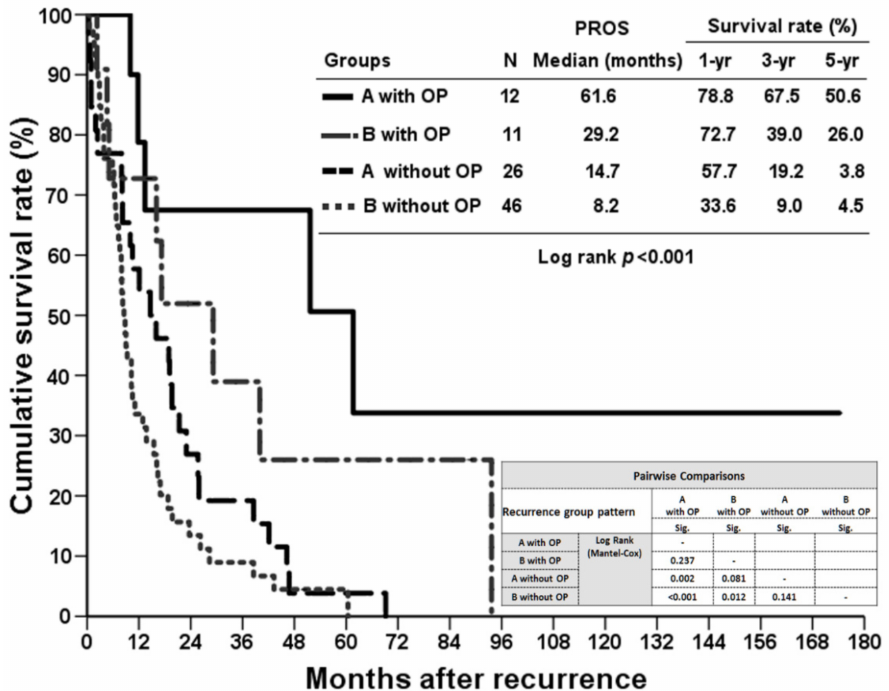
Figure 6. The post-recurrence overall survival (PROS) according to the types of surgery applied within groups A and B. The first line indicates that the patients with isolated intrahepatic recurrence underwent repeat hepatectomy alone in group A ( n = 12), compared to the third line, which represents the nonoperative patients ( n = 26) within group A. The second line indicates the patients with locoregional recurrence who underwent hepatectomy or/with metastatectomy in group B ( n = 11), and the fourth line indicates the nonoperative patients within group B ( n =